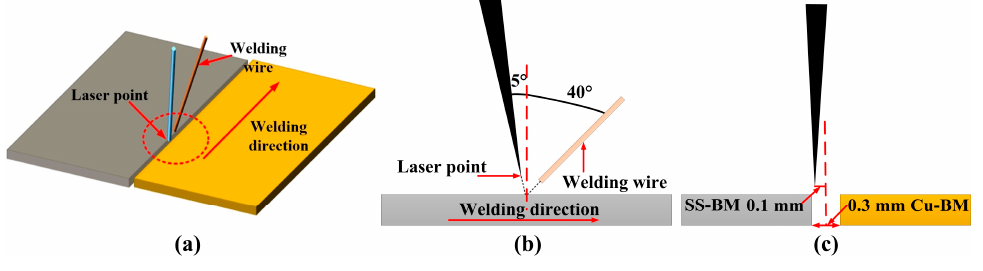
Figure 1. Schematic overview beam offset application. Table 3. Welding parameters used in this experiment.